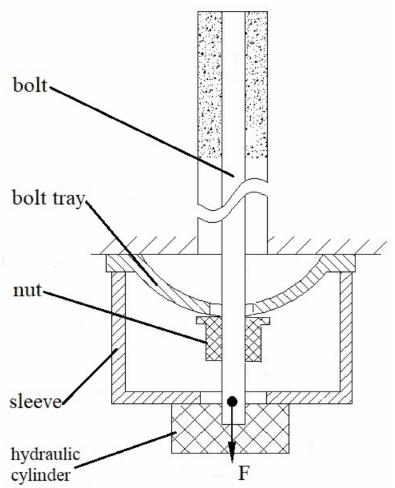
Figure 14. Schematic diagram of the bolt pull-out test.